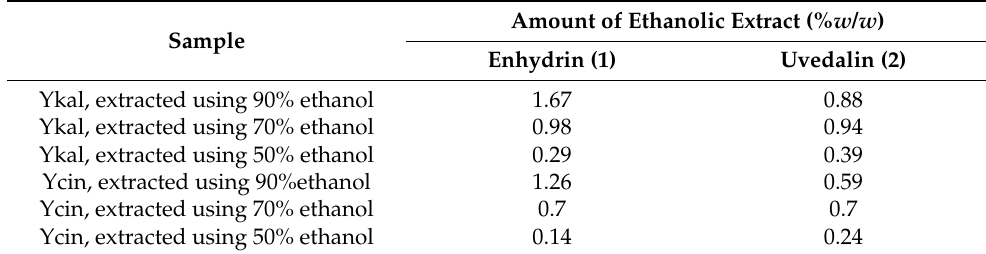
Table 5. Assay of enhydrin and uvedalin in yacon leaf ethanolic extract.